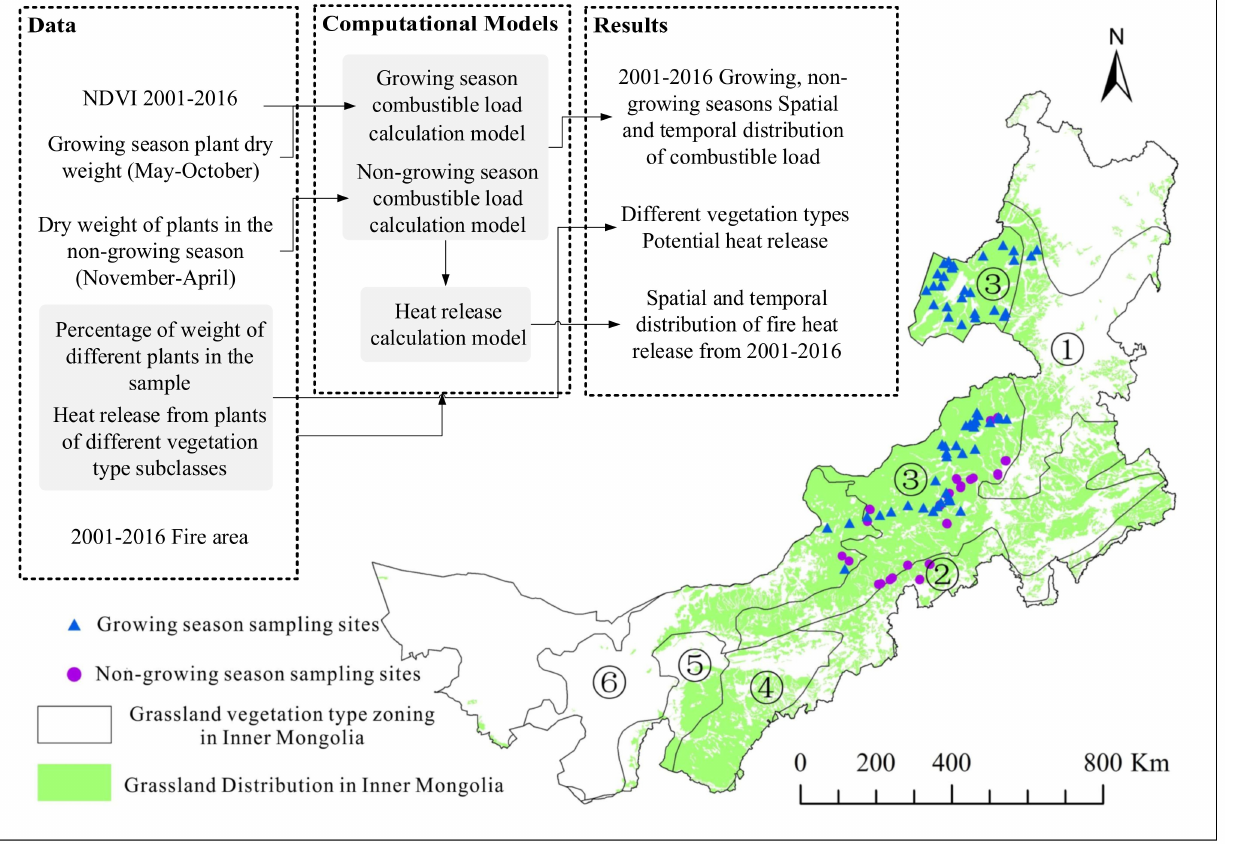
Figure 1. Field sampling sites and technical roadmap (Note: 1 (cid:13) northern temperate meadow grasslands; 2 (cid:13) southern temperate meadow grasslands; 3 (cid:13) northern temperate typical grasslands; 4 (cid:13) southern temperate typical grasslands; 5 (cid:13) southern temperate desert grasslands; 6 (cid:13) temperate shrub desert